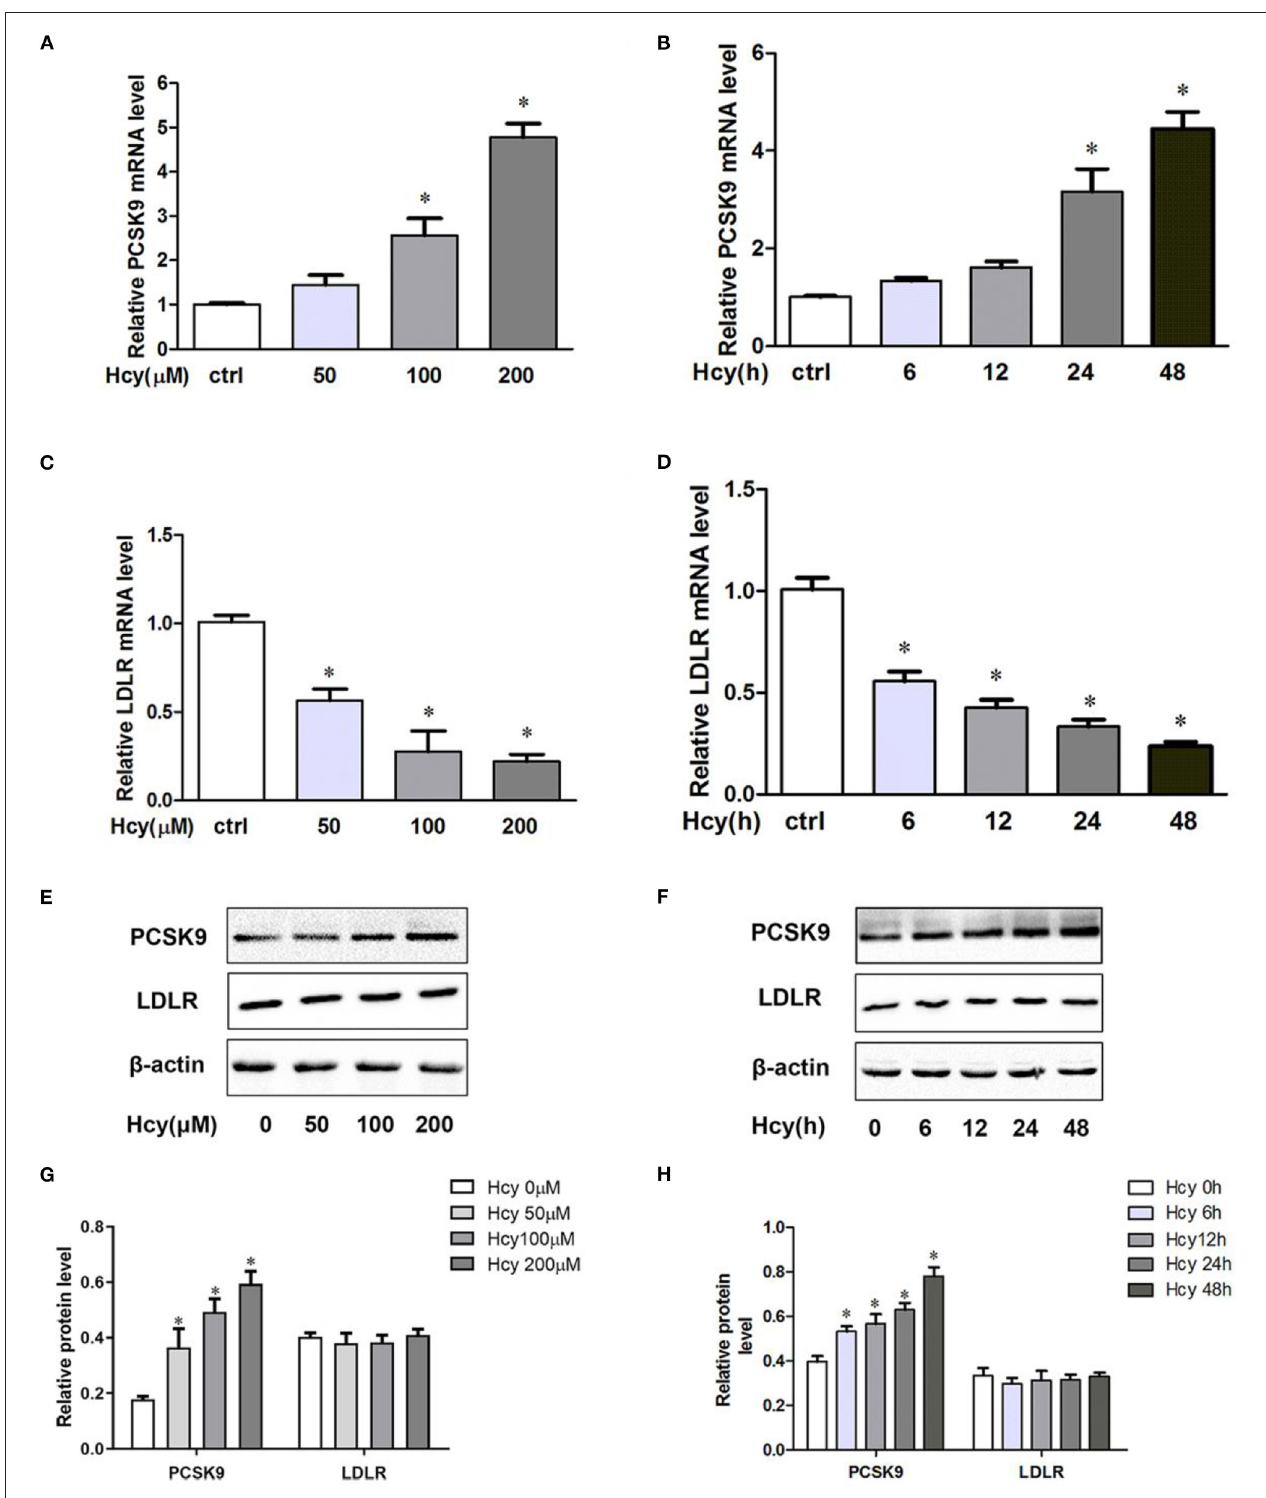
FIGURE 1 | Homocysteine(Hcy) increased proprotein convertase subtilisin kexin 9(PCSK9) level in THP-1 macrophages, and SBC-115076 reversed this effect. THP-1 macrophages were treated different concentrations of Hcy (50, 100 and 200 µ mol/L) (A,C) or vehicle (equivalent volume of PBS) for 24h or incubated with 100 µ mol/L Hcy under different exposure times (0, 6, 12, 24, and 48h) (B,D) . The mRNA levels of PCSK9 and LDLR were analyzed by real-time quantitative PCR. The protein levels of PCSK9 and LDLR were measured by western blot analysis (E–H) . Data represent mean ± standard error of the mean (SEM). Each experiment was performed three times. * p < 0.05 vs. the control group (Hcy 0 µ mol/L, which refers to incubation with PBS only). Hcy, homocysteine.